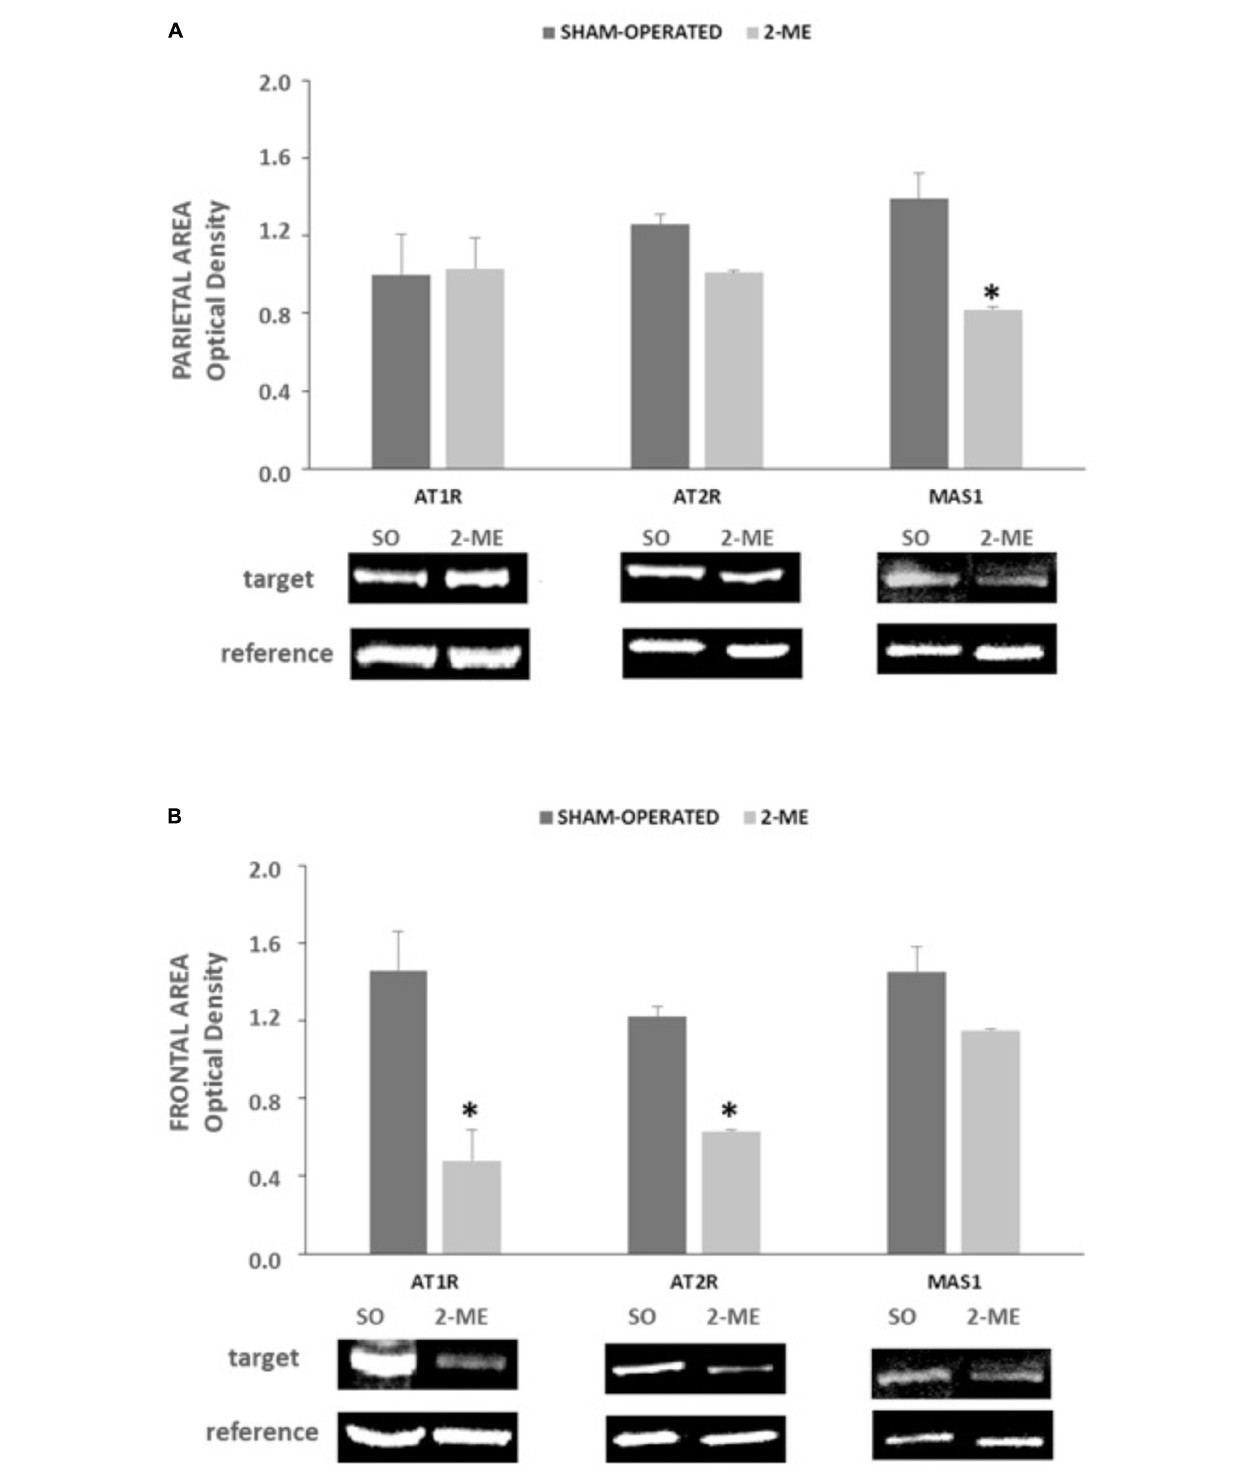
FIGURE 4 | AT1R, AT2R e MAS1 protein levels in SO ( N = 2) and 2-ME ( N = 3) rats. Data are represented as mean ± SEM. Histograms representing the Optical Density of target proteins (AT1R, AT2R, and MAS1) normalized to the Optical Density of the housekeeping proteins (GAPDH for AT1R and HPRT for AT2R and MAS1) are represented in panel A (data from the parietal area) and panel B (data from the frontal area) of SHR cerebral cortex. ∗ p < 0.05 vs. SO.”